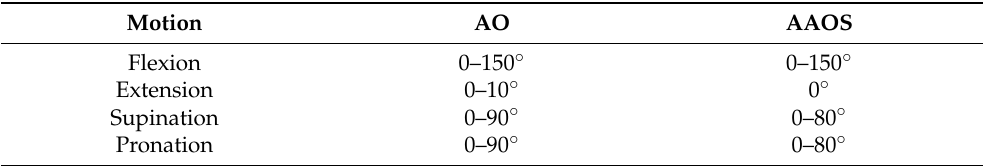
Table 1. Normal elbow mobility values provided by the Association for the Study of Osteosynthesis and the American Academy of Orthopaedic